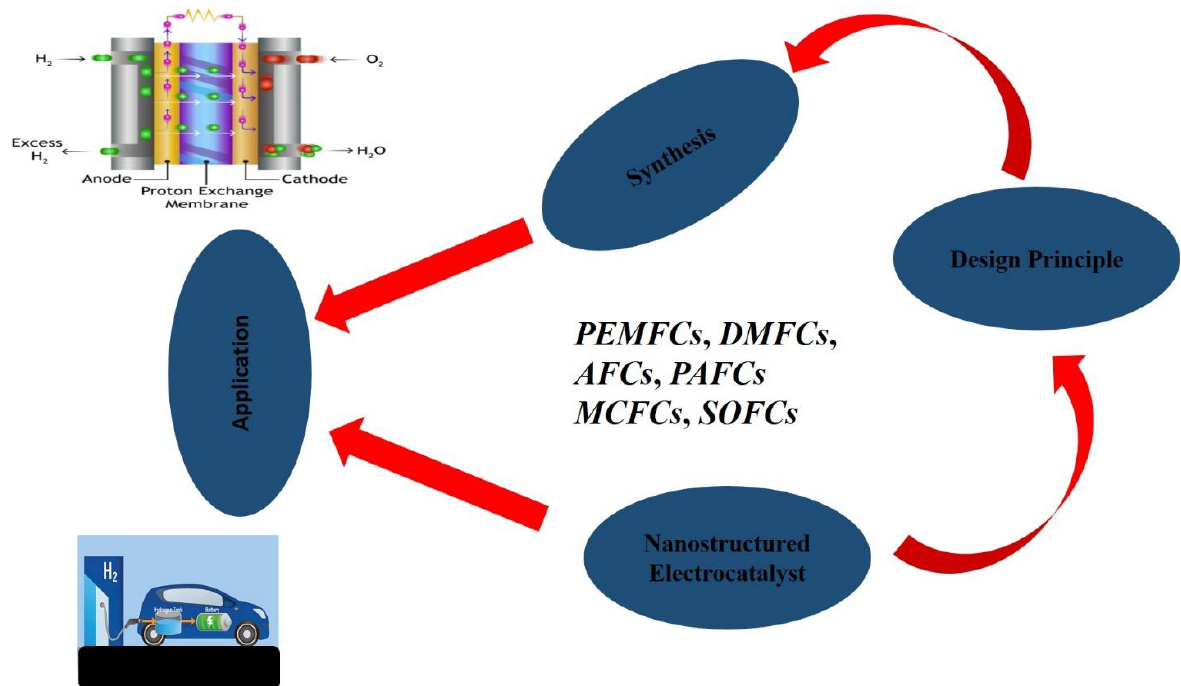
Figure 3. A simplified overview of the process flow that involves the use of nanostructured electro- catalyst in fuel cells.